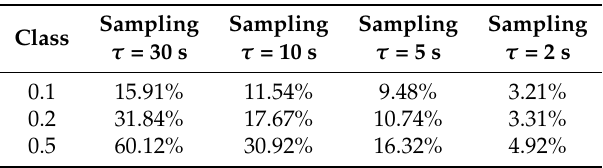
Table 6. Mean relative error of the line temperature estimation method for an incomplete set of noise-containing data.